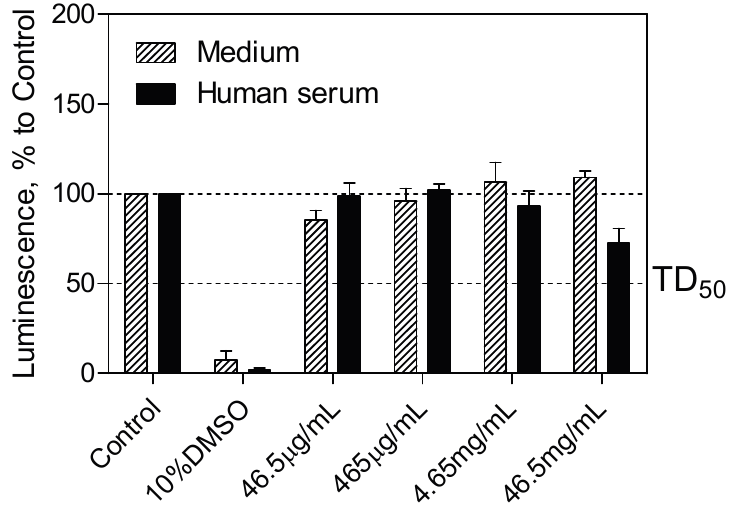
Figure 4. pEND cell viability assay to measure SEV-SBE β CD toxic effect over time (24 h). The luminescence is measured in percentage to a control group (untreated cells). 10% solution of DMSO was used as positive control. The median toxic dose level is abbreviated as TD 50 . The thresholds are depicted as dashed lines. Data represent means ± standard